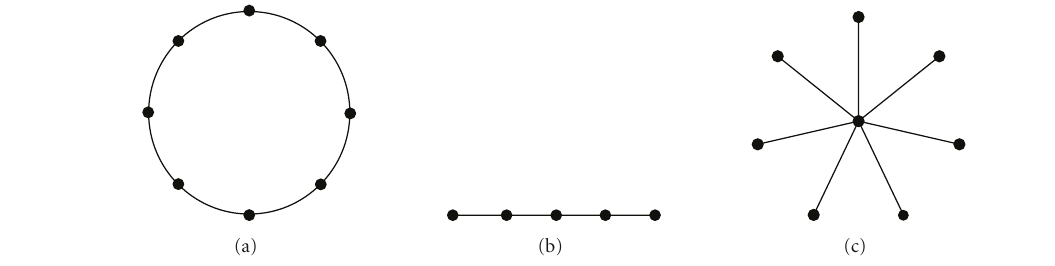
Figure 4: Structured networks: (a) R 8 , (b) P 5 , (c) S 8 .